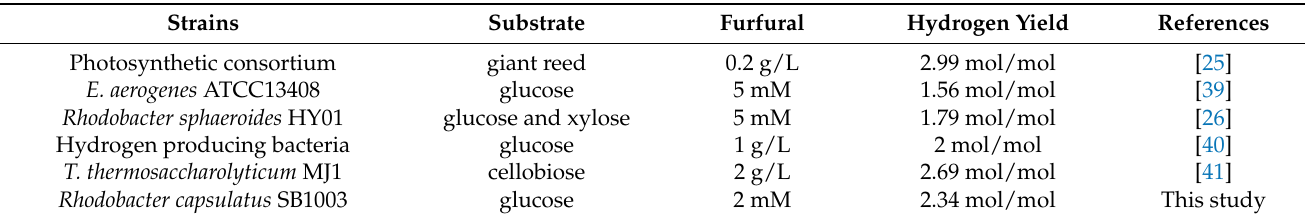
Table 2. Comparison of furfural inhibition on hydrogen fermentation.